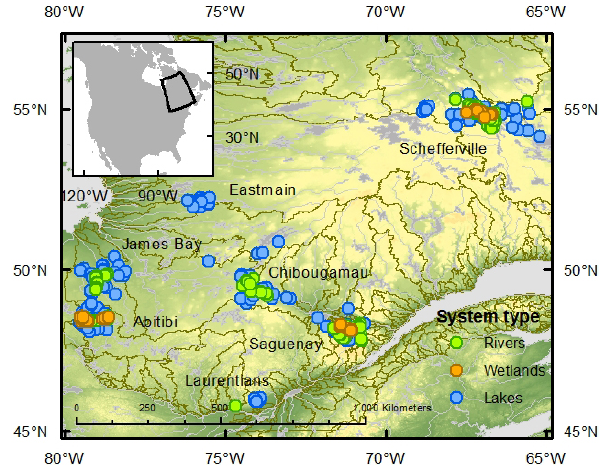
Figure 1. Distribution of the sampling sites across seven boreal re- gions (James Bay, Abitibi, Laurentians, Saguenay, Chibougamau, Schefferville) of Quebec, Canada. Grey lines and areas represent large rivers and lakes; green lines delimit the main watersheds in